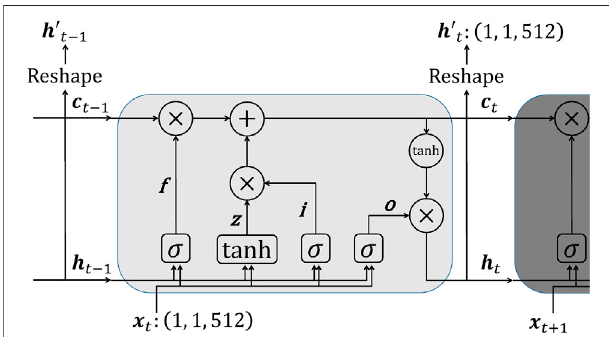
FIGURE 3 | The architecture of LSTM. The input to LSTM ( x t ) is the vectortransformedfrom animage ofdensity distribution,and the output isthe reshaped hidden state vector ( h t ′ ) resulting from several operations. The vector c is the memory cell, and f , i , o , and z are a forget gate, an input gate, an output gate, and part ofthe term to be added tothe memory cell (see equations ( 7 ) to ( 10 ) for details).